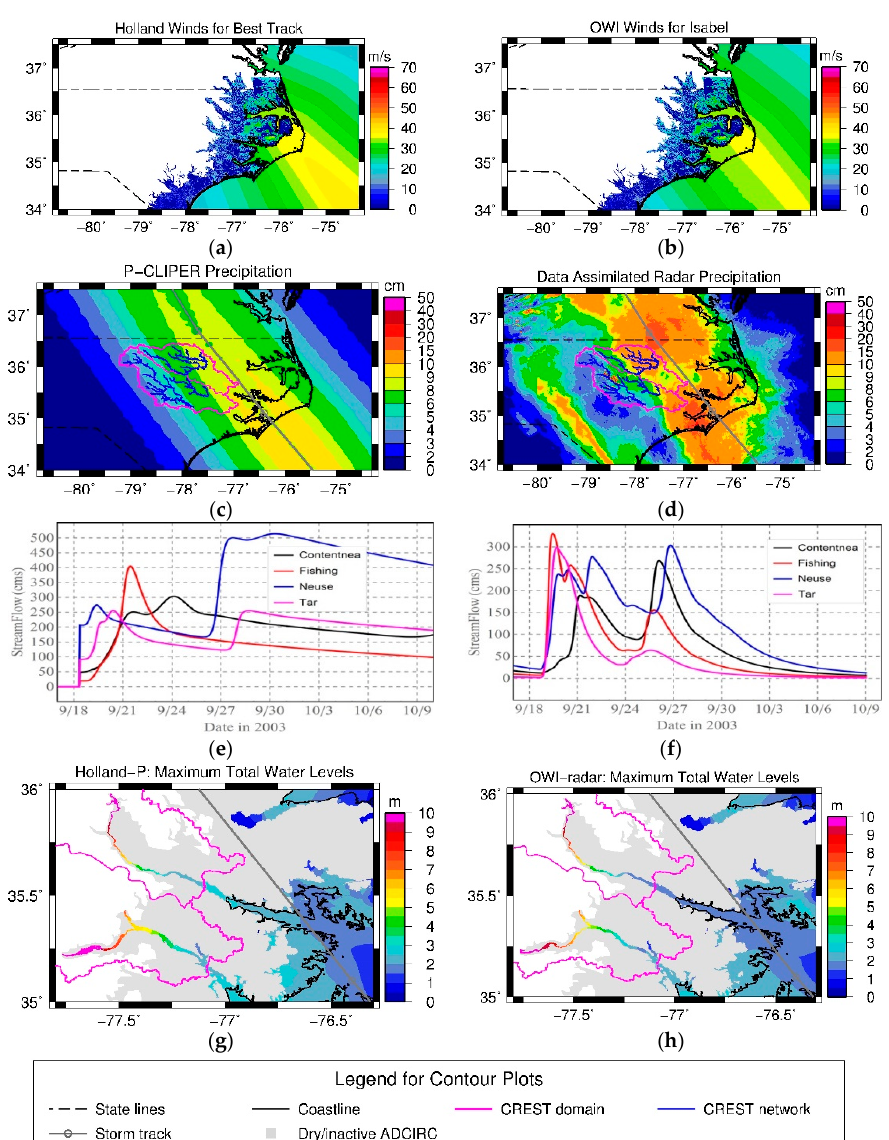
Figure 3. Results for Hurricane Isabel using the best-track within the STORM-CoRe system (panels a c e and g) and optimized wind fields and radar precipitation (panels b d f and h): ( a ) wind field (m/s) generated in ADCIRC with Holland model, ( b ) OWI wind field (m/s), CREST stream network overlaid on cumulative precipitation (cm) from ( c ) P-CLIPER and ( d ) radar, ( e ) and ( f ) hydrographs (cms) at four handoff points from CREST, ( g ) and ( h ) maximum total water elevation (m) for combined storm and river spindown in the study region.